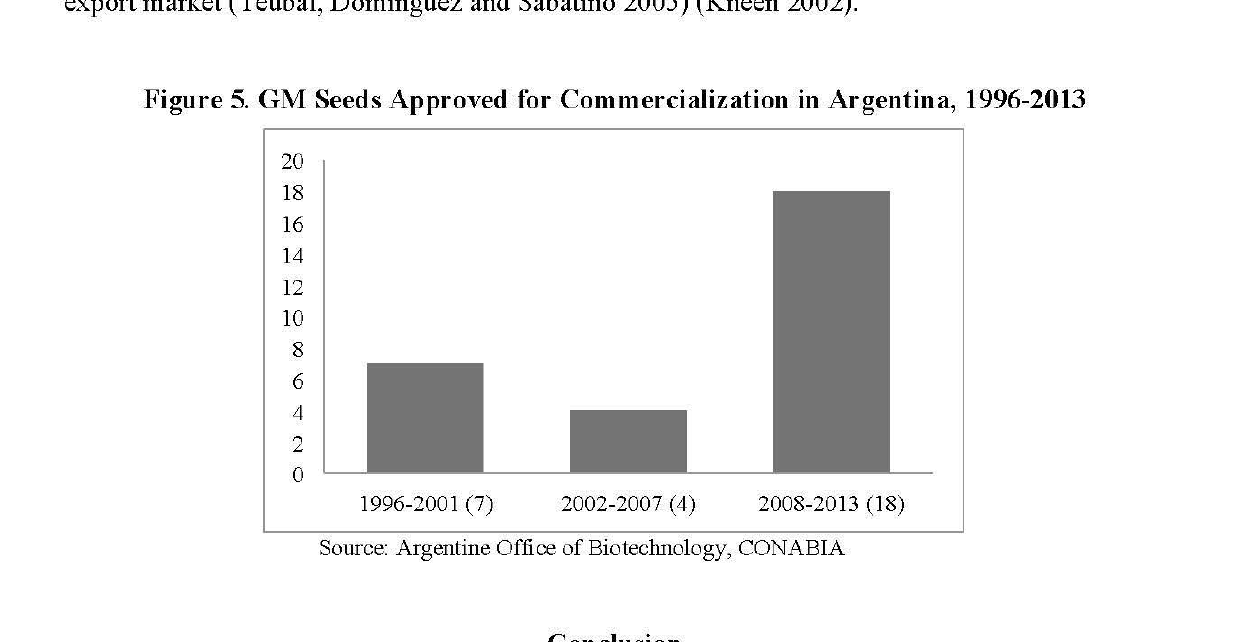
Source: Argentine Office of Biotechnology,